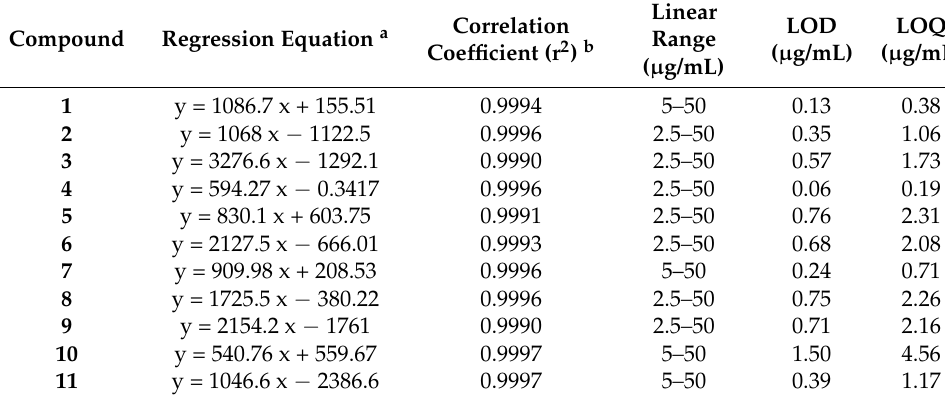
Table 3. Calibration curves and Linear range of compounds 1 – 11 .